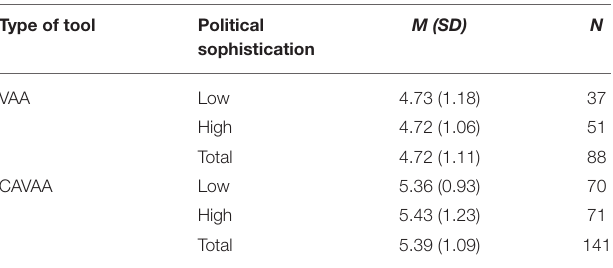
TABLE 1 | Means and Standard Deviations of the (CA)VAA experience (ranging from 1 – a low evaluation to 7 – a high evaluation) in each condition. Type of